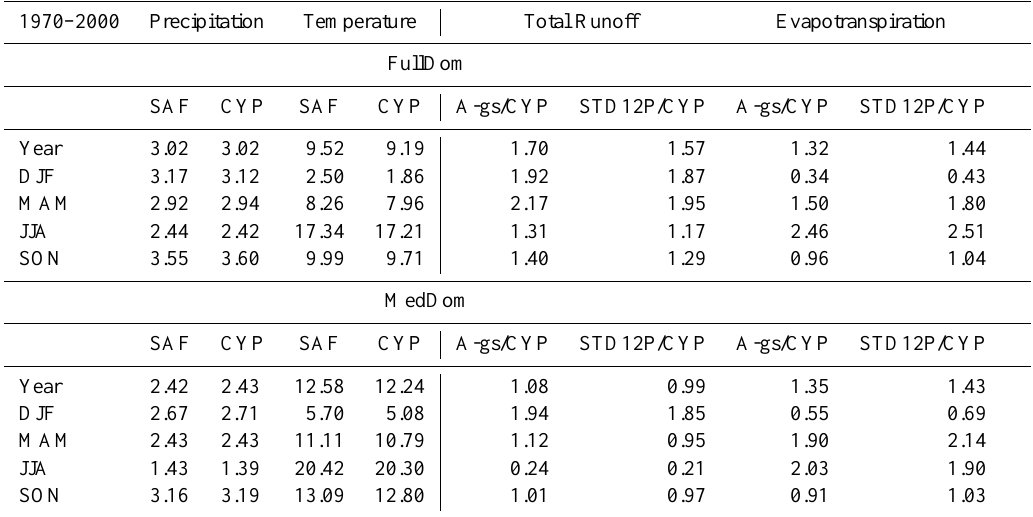
(FullDom) and for the southern part of the domain (MedDom) for the end of the 20th century. SAF corresponds to the SAFRAN gridded database, CYP to the CYPRIM climate forcing, A-gs/CYP to the ISBA-A-gs version with the CYPRIM scenario, and STD12P/CYP to the ISBA-Std12P version with the CYPRIM scenario.